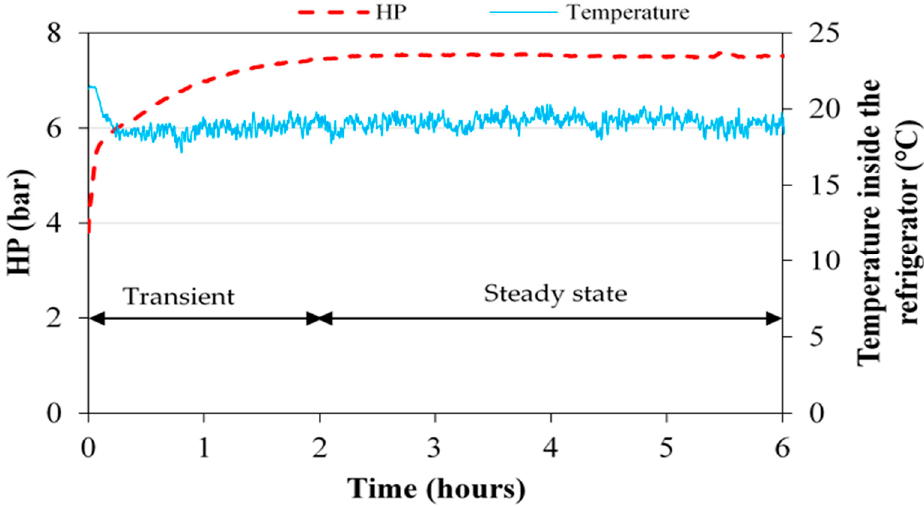
Figure 8. High pressure and the temperature of the air inside the refrigerator during a start-up test in continuous mode.